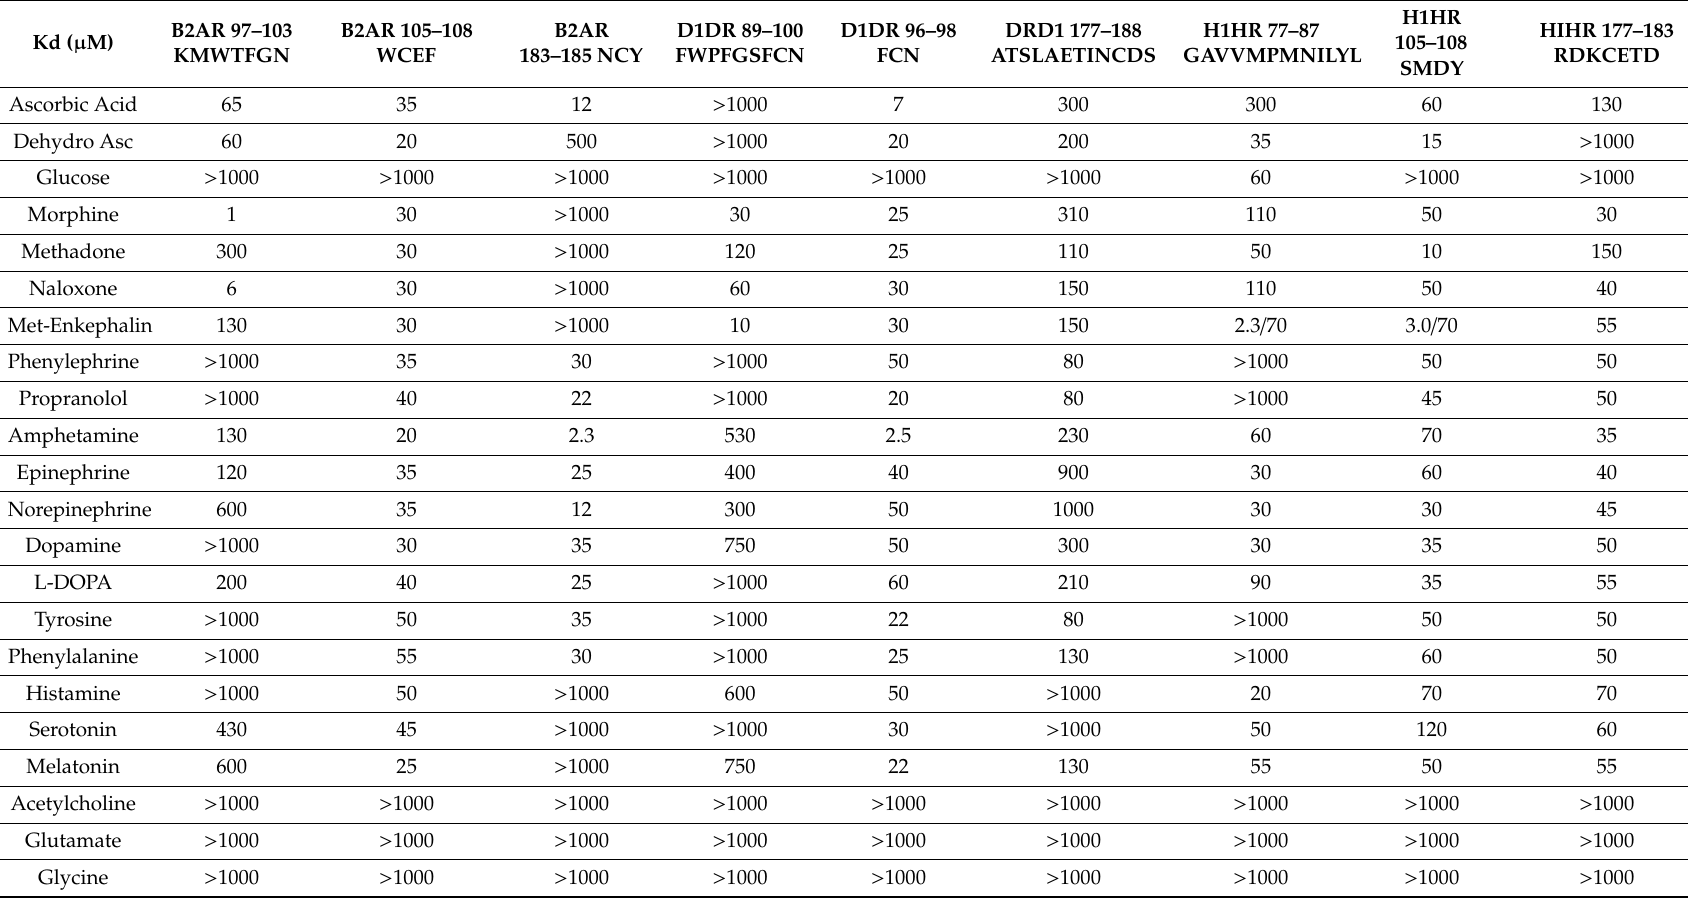
Table 2. Summary of ultraviolet spectroscopy studies of the binding of various compounds to peptides: Glut RED = reduced glutathione; Glut Ox = oxidized glutathione; B2AR = beta 2 adrenergic receptor; D1DR = dopamine 1 receptor; H1HR = histamine 1 receptor; Dehydro Asc = dehydroascorbic acid; L-DOPA =